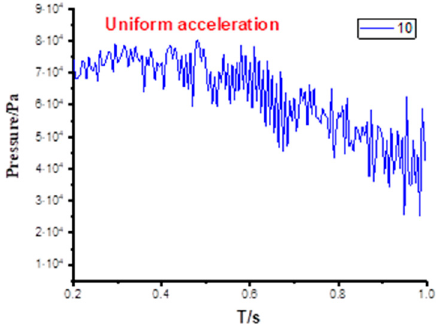
Figure 14. Cavitation pressure distribution at the support plate.